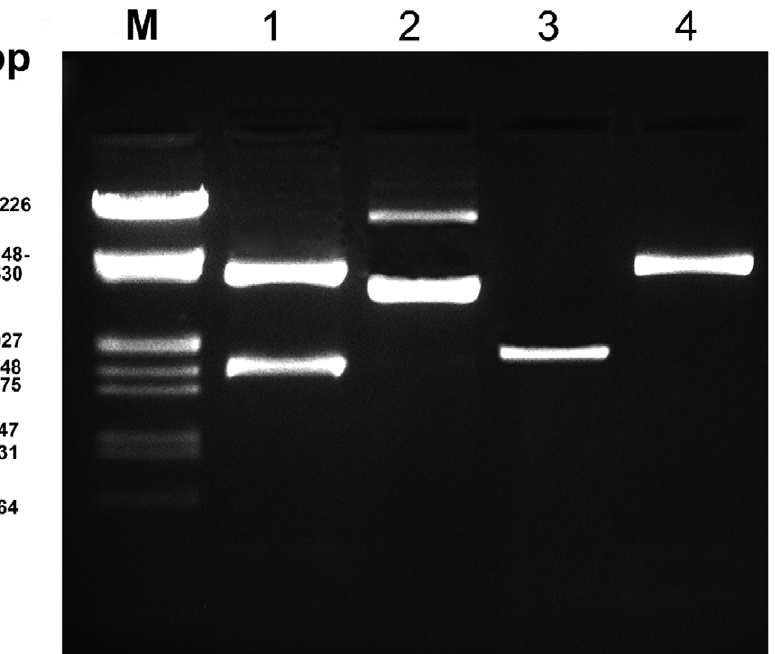
Figure 1. Electrophoretic analysis of restriction mapping. Lane 1 shows the pCR H 2.1-TOPO H vector (3923 bp) above, which is cleaved by EcoRI (Invitrogen, Karlsruhe) and below the amplified 18S rRNA gene fragment (1724 bp) with the correct orientation (lane 2 with the incorrect orientation). The controls show the amplified PCR product (lane 3) and vector without insert (lane 4). M: marker l -EcoRI + HindIII-Marker-Mix 3 (Fermentas, St. Leon-Rot) 1 m g.